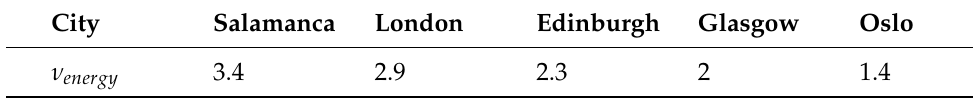
Figure 12. Waste impact comparison between the RESCATAME implementation and the green solution in the different cities of installation. Table 9. Energy impact ratio between RESCATAME and baseline